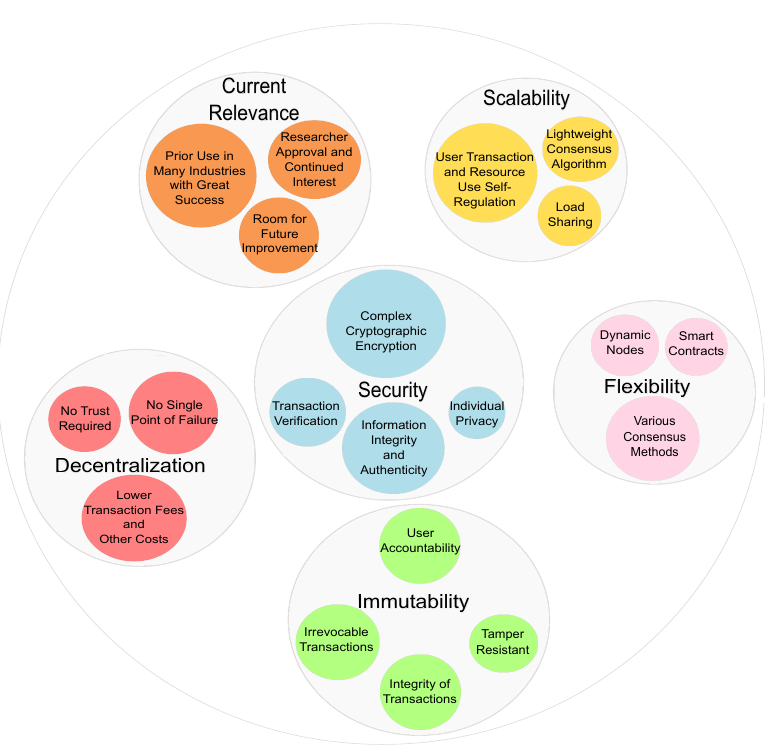
Figure 6. The attribute graph of the security concerns of connected and autonomous vehicles (CAVs) that blockchain technology can